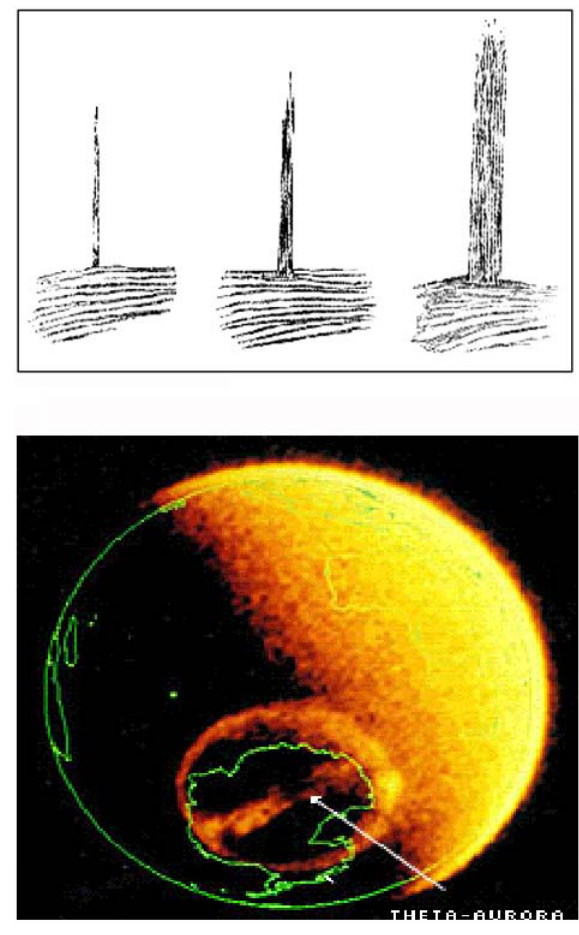
Fig. 14. Theta aurora from the Dynamic Explorer satellite imager and a sketch of a similar aurora by Sykora.